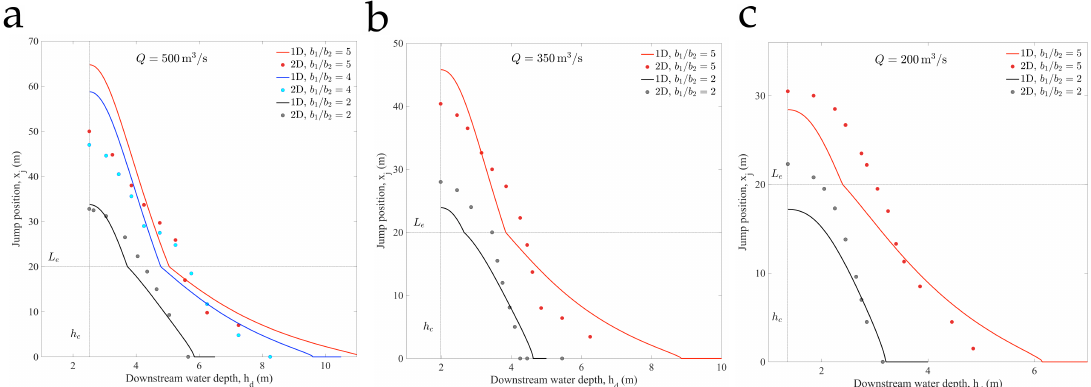
Figure 14. Comparison between 1D (solid lines) and 2D (circles) predictions of the jump location downstream of a channel contraction: summary of results. We plot the jump position, x j , as a function of imposed downstream water depth, h d , for three flow discharges, Q = 500,350 and 200 m 3 /s (panels a , b and c , respectively), and several width ratios, b 1 / b 2 = 2,4,5. The jump is repelled out of the expansion zone when x j > L e , and the flow becomes fully subcritical when x j =